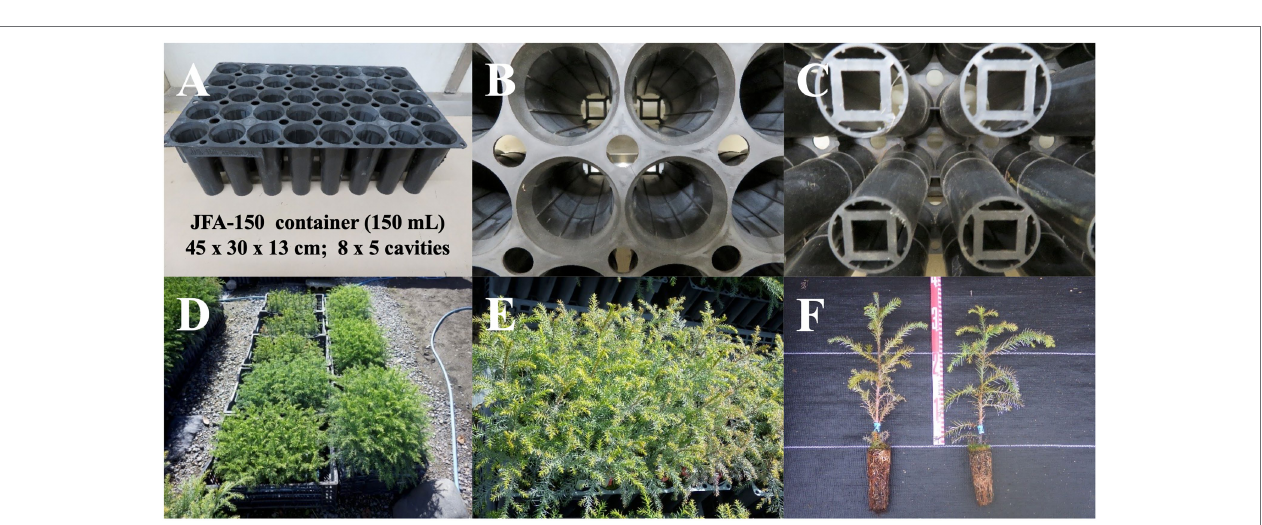
FIGURE 5 | Containerized somatic seedlings of pollen-free sugi ( C. japonica ). (A) JFA-150 container. (B) View of the ribs on the inner wall of the cavity. (C) Bottom of the container. (D) An example of the growth status of containerized somatic seedlings derived from different embryogenic cell lines. (E,F) Containerized seedlings with heights of more than 30 cm, suitable for planting in the